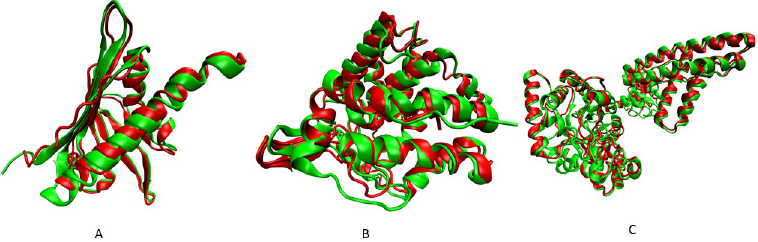
Fig 3. Results of REDCRAFT structure calculation (in red) compared to the reference structure (in green) A) ChR145, B) LpG1496 and C) Enzyme 1 from E . coli